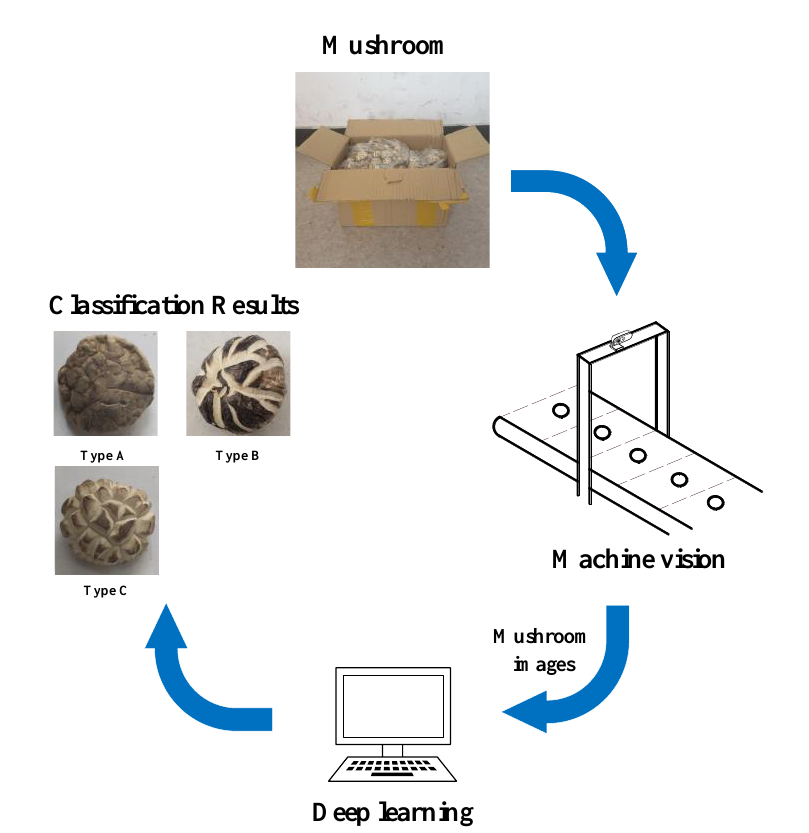
Figure 4. Workflow of deep-learning-based wireless visual sensor system.